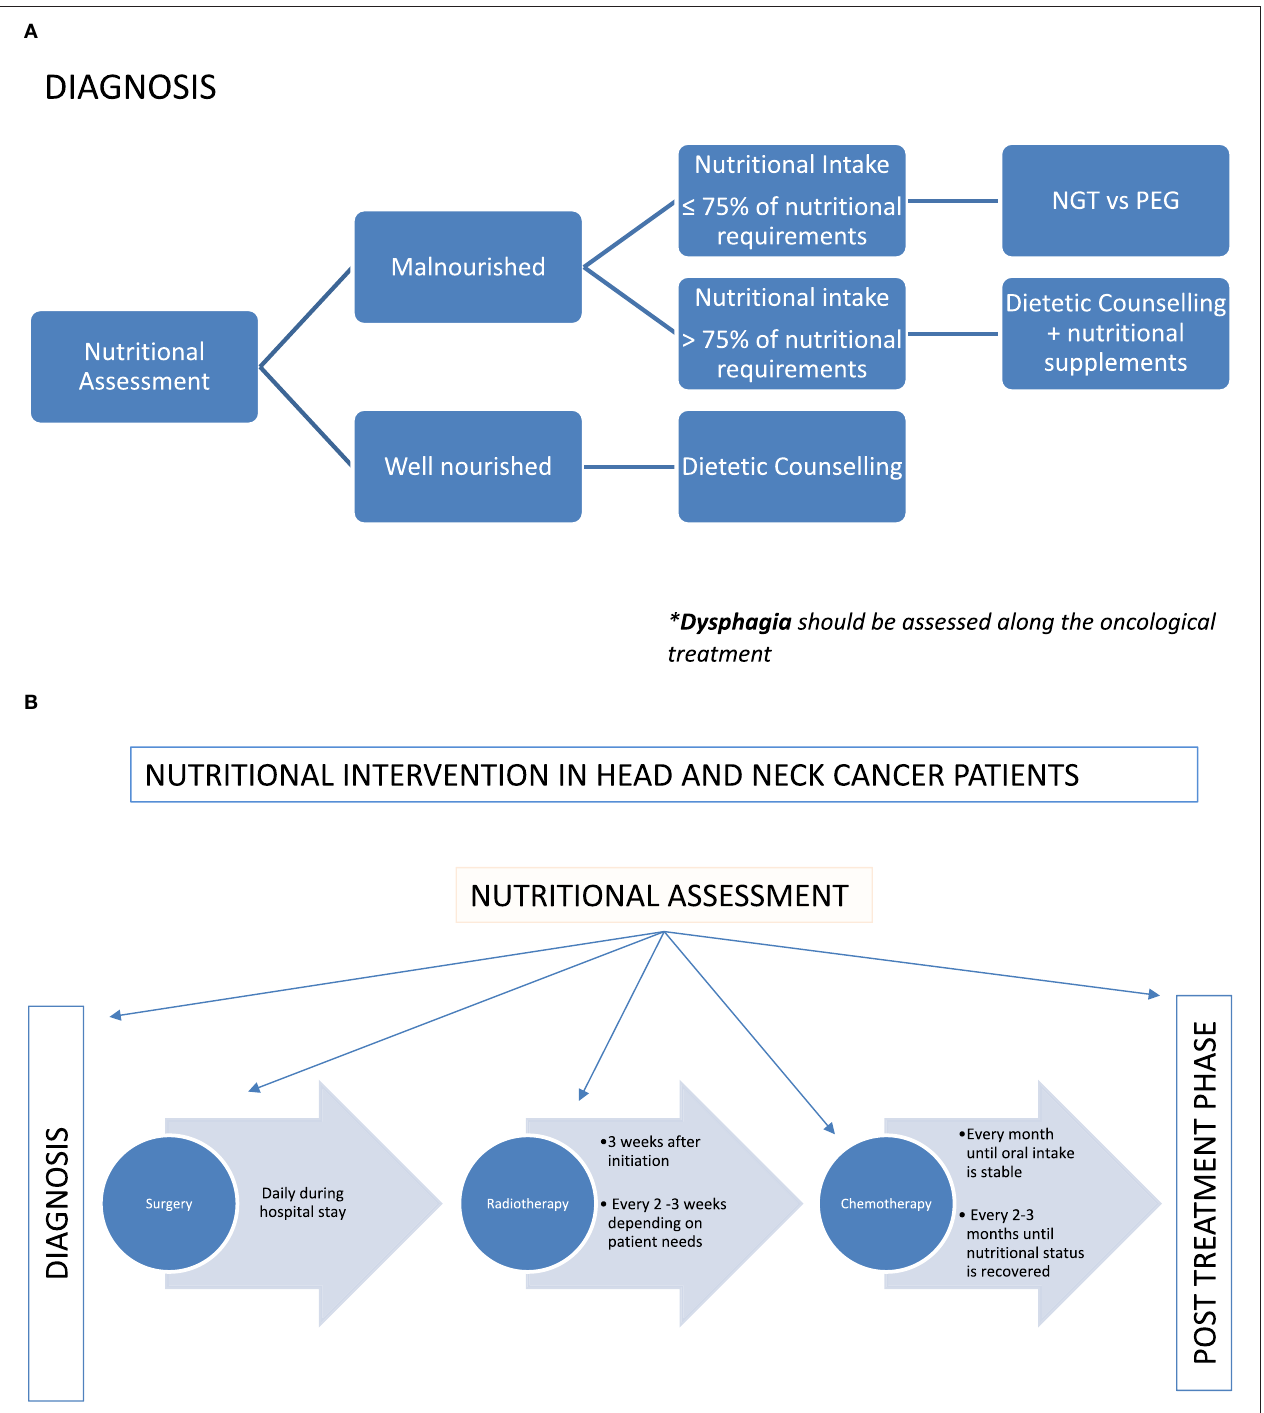
FIGURE 1 | (A) Nutritional intervention in HNC patients according to the nutritional status. (B) Nutritional intervention in HNC patients according to the treatment plan. psychosocial sequelae and diminished quality of life. This is especially common among patients with HNC, and it is important to help them coping with these psychosocial aspects into their routine cancer care throughout the illness